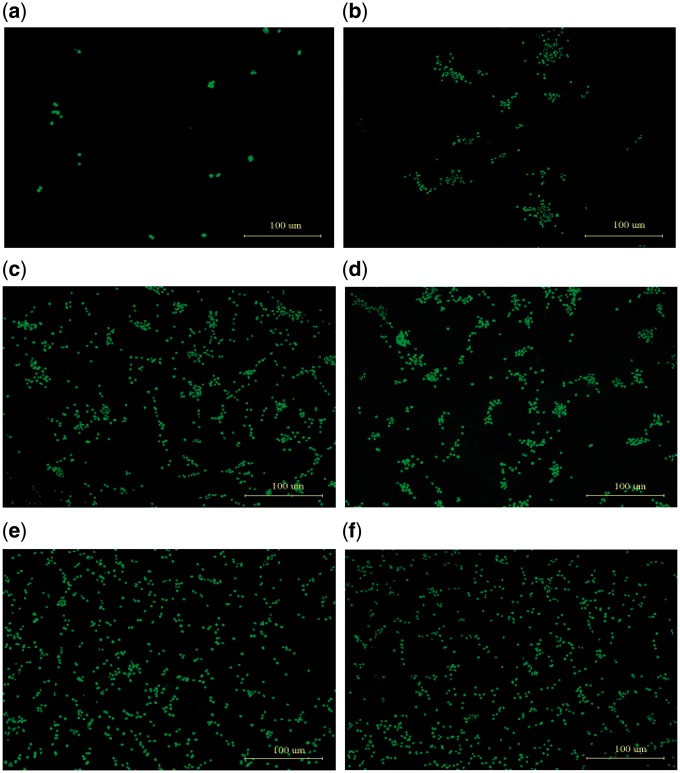
The fluorescence microscopy images of the PC12 cells cultured on chitosan films treated with NaOH solution for different time. (a) 0 h, (b) 2 h, (c) 4 h, (d) 8 h, (e) 12 h and (f) 24 h. Green fluorescence shows cell nuclei